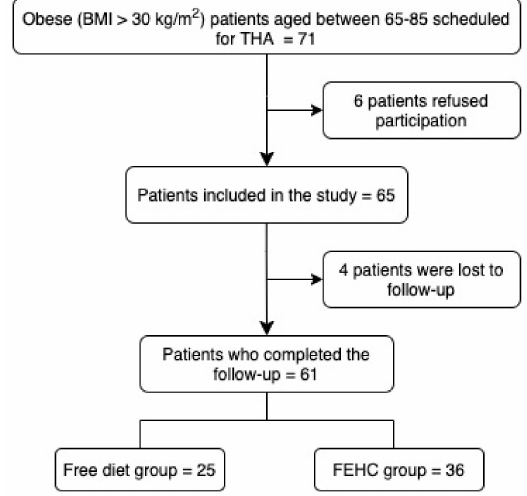
Figure 1. Patient inclusion